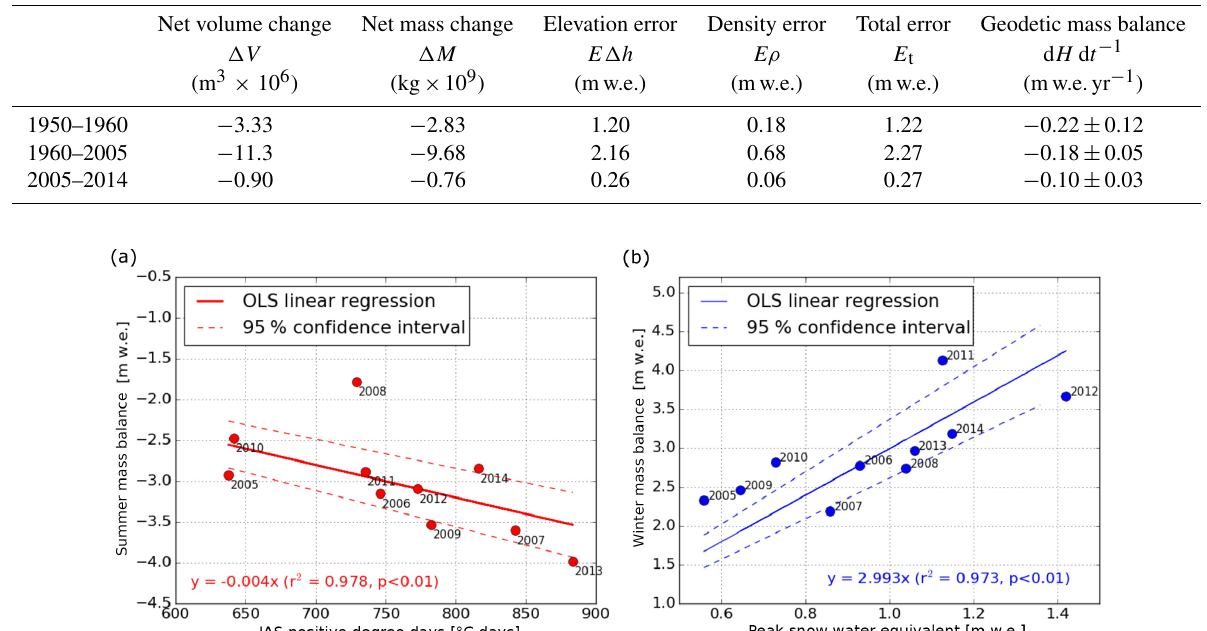
Figure 4. Ordinary least squares (OLS) linear regressions between climate data and glaciological mass balance for 2005–2014. (a) Summer (i.e., July, August, and September: JAS) positive degree days versus summer mass balance. The linear regression is shown in red text and is plotted (solid red line). The 95% confidence interval on the regression is also shown (dotted red lines). (b) Peak snow water equivalent (SWE) versus winter mass balance. SWE data are from the Mount Allen snow course. The linear regression is shown in blue text and is plotted (sold blue line). The 95% confidence interval on the regression is also shown (dotted blue